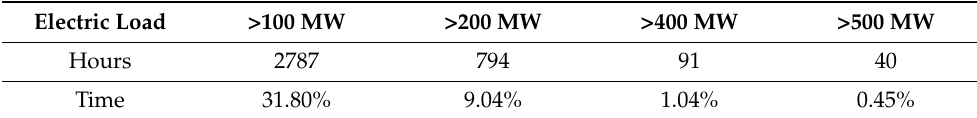
Table 5. Forecast error duration curve for FCM ReNFuzz-LF